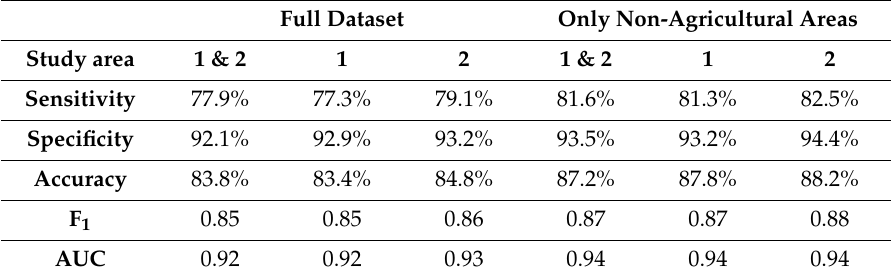
Table 5. Accuracy metrics of the field boundary detection for the test